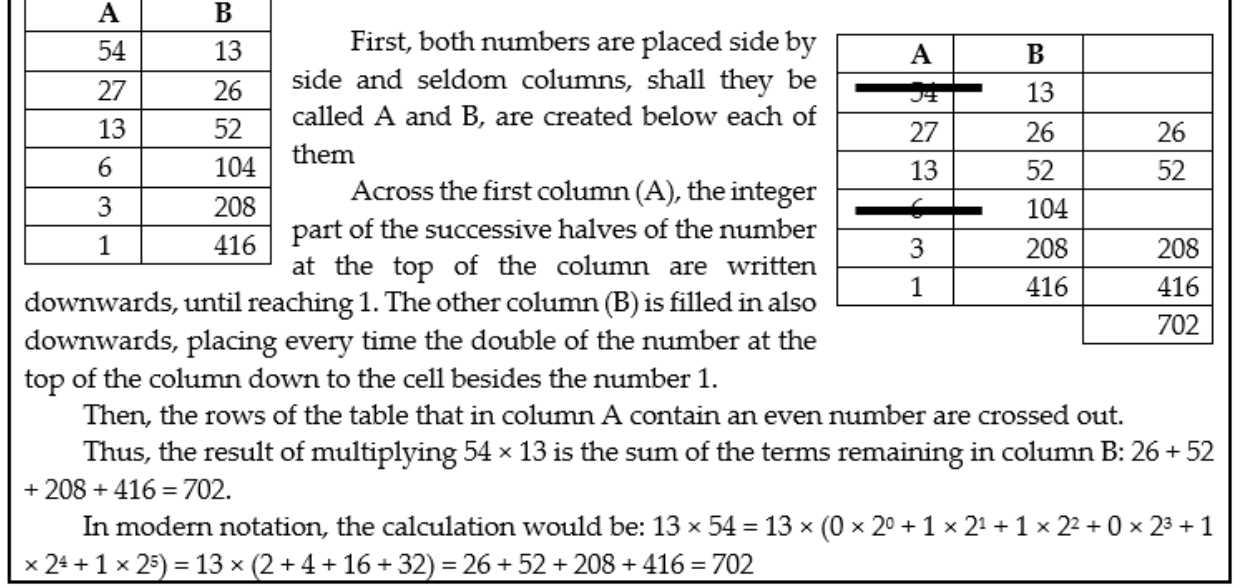
Figure 2. Description of the Russian peasants’ multiplication method as presented to the students.